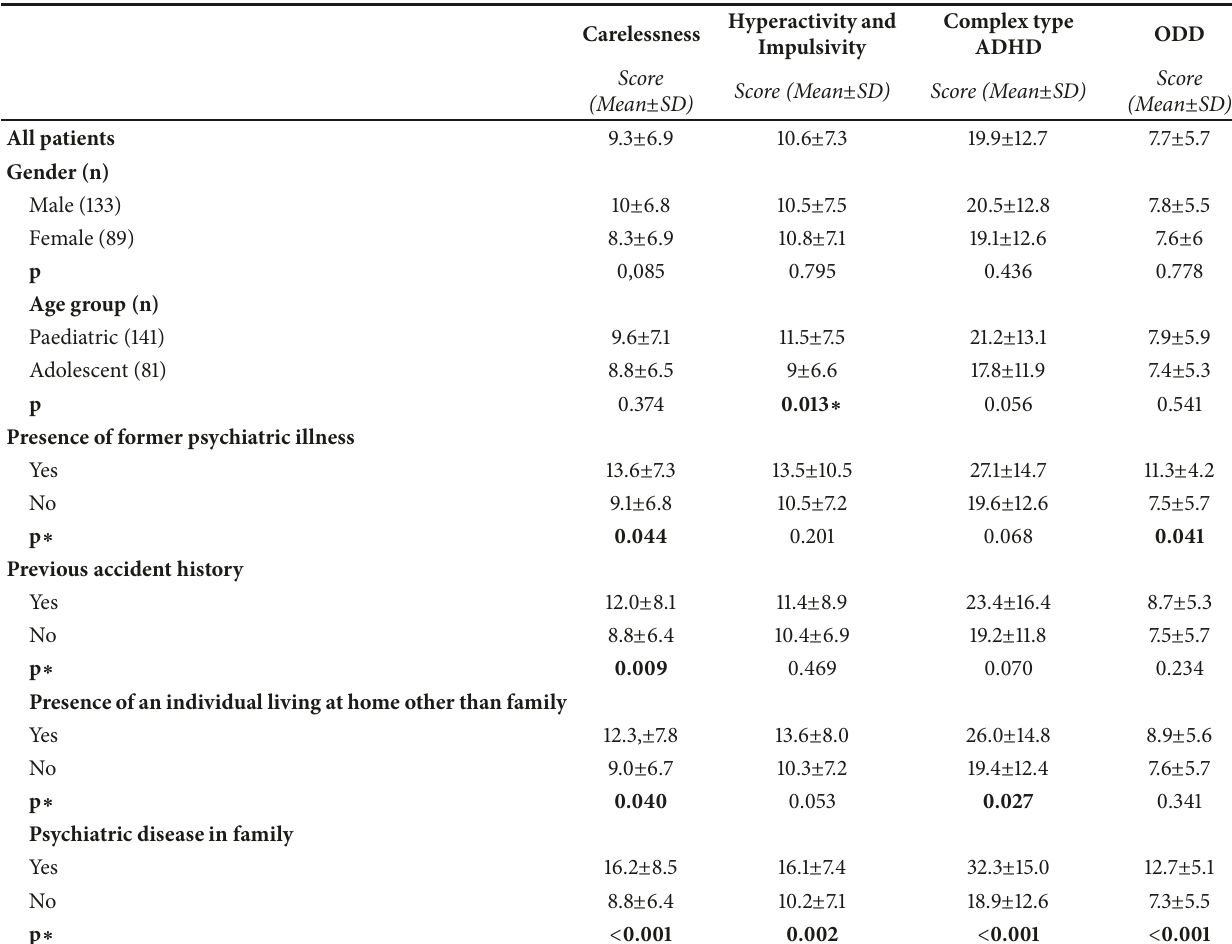
Table 2: Relation between scale scores and demographic